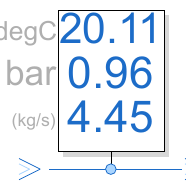
Figure 5. Exemplary sensor displaying three